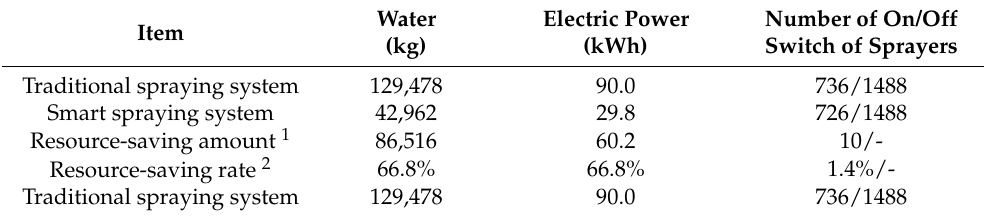
Table 8. Comparison between traditional and smart microclimate-control systems regarding the resource consumption of spraying for environmental